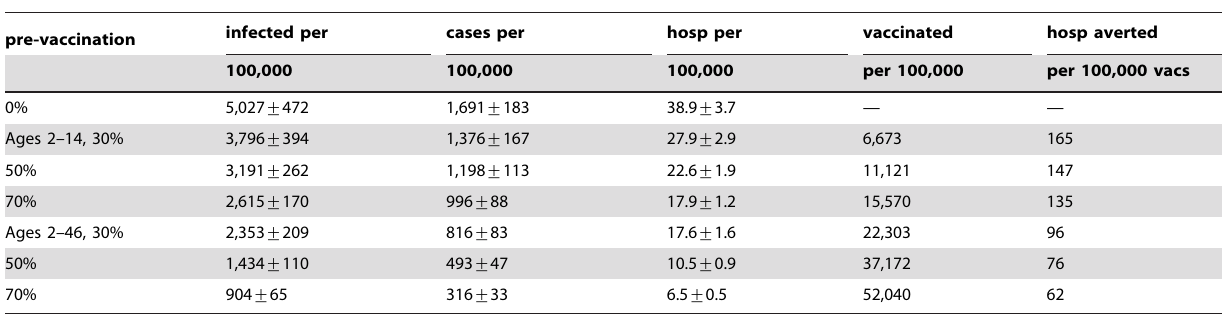
Table 1. Single year dengue simulation